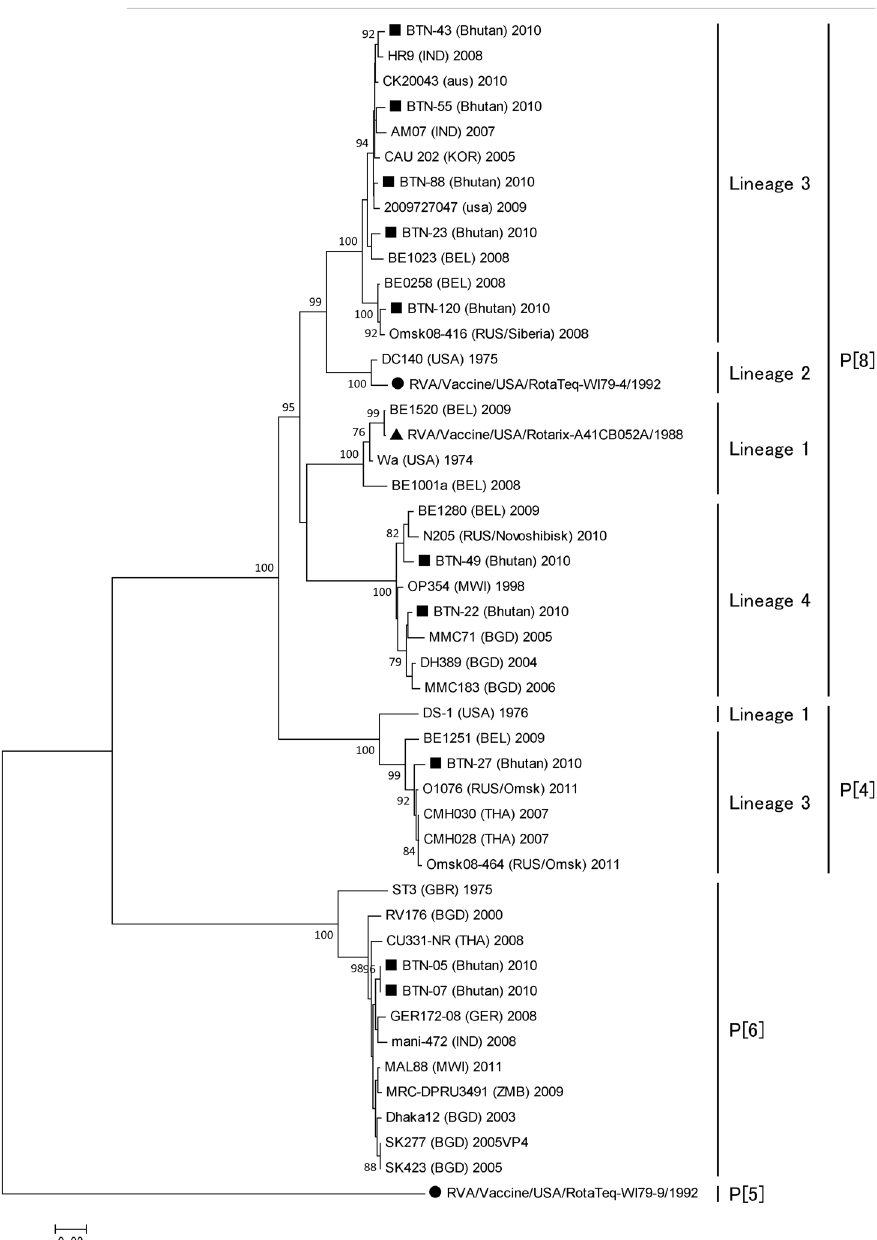
Figure 6. Phylogenetic tree constructed based on the deduced amino acid sequences of the VP8* genes of G1, G9, and G12 strains from Bhutan and global P [8] , P [6] , P [5] , and P [4] strains. The species and country of origin are shown in parentheses after the strain name. The numbers adjacent to node represent the bootstrap values; values , 70% are not shown. The scale bar shows the genetic distance, which is expressed as amino acid substitutions per site. The DNA Data Bank of Japan/European Molecular Biology Laboratory/GenBank accessions numbers are: AB905368 (rotavirus strain BTN-05), AB905369 (BTN-07), AB905370 (BTN-120), AB905371 (BTN-23), AB905372 (BTN-88), AB905373 (BTN-49), AB905374 (BTN-22), AB905375 (BTN-27), AB905376 (BTN-43), AB905377